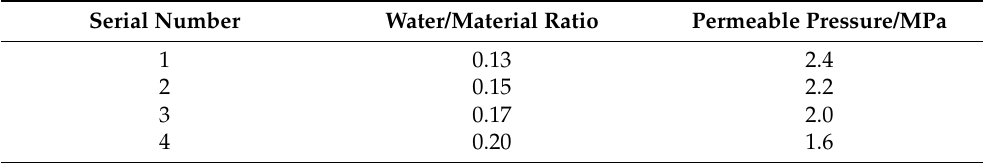
Table 3. Impermeability test